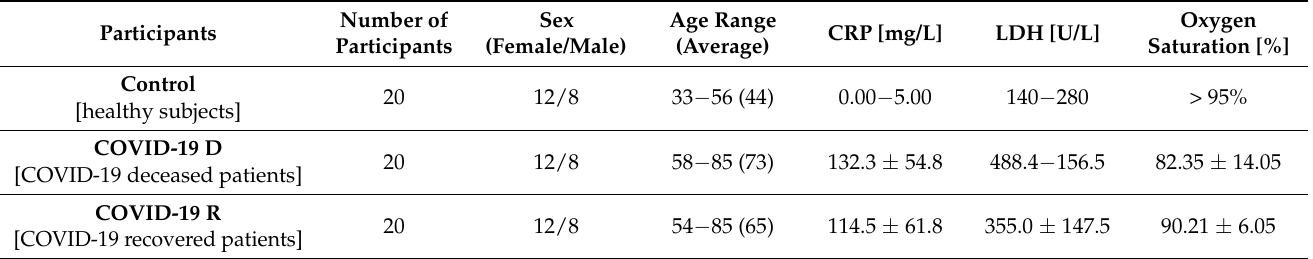
Table 1. Characteristics of COVID-19 deceased [COVID-19 D] and COVID-19 recovered patients [COVID-19 R] compared to healthy subjects [Control] .